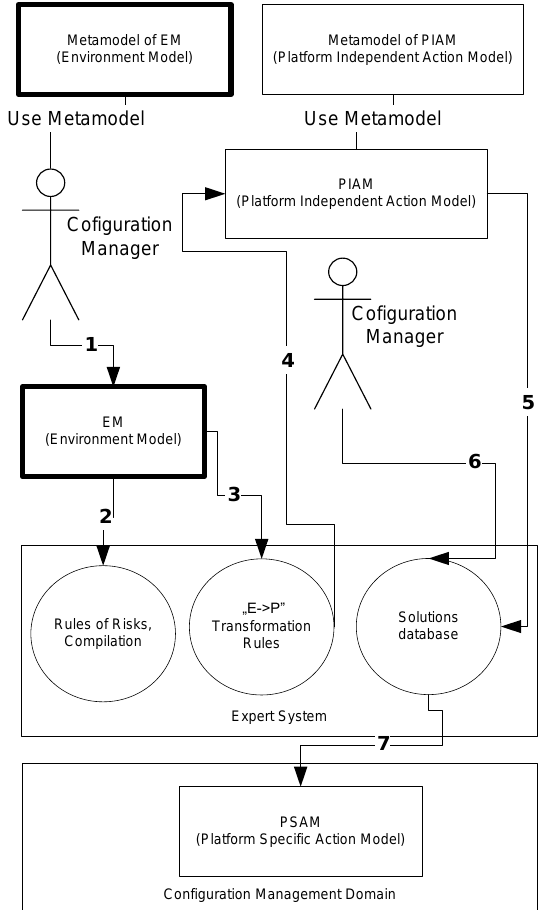
Fig. 1. Model-based approach for software configuration management. Illustration of a model-driven approach in Fig. 1 is represented as a flow with interactions from a